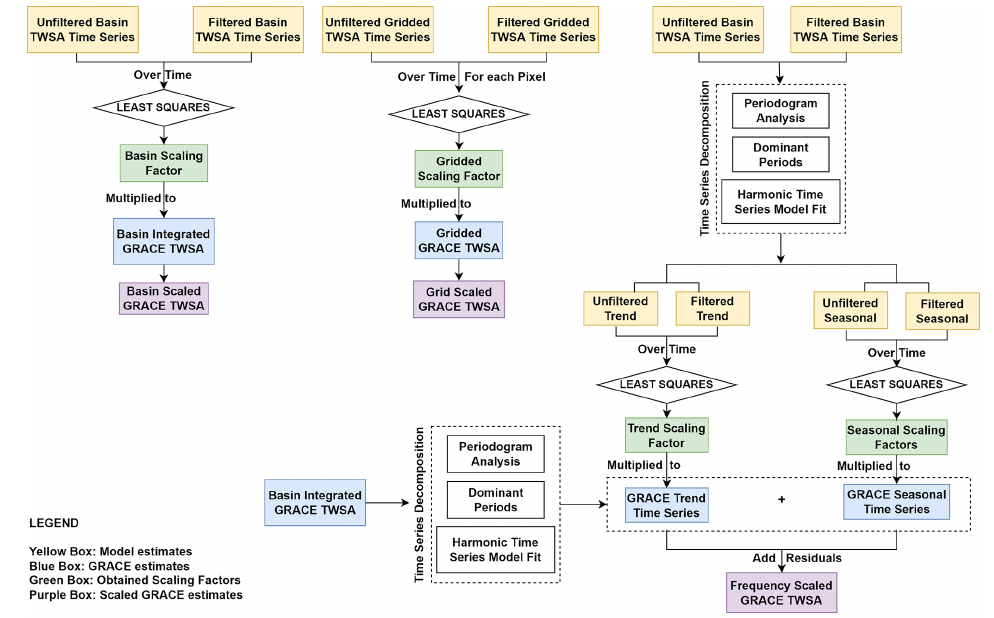
Figure 3. The schematic diagram for deriving and applying the three scaling schemes.